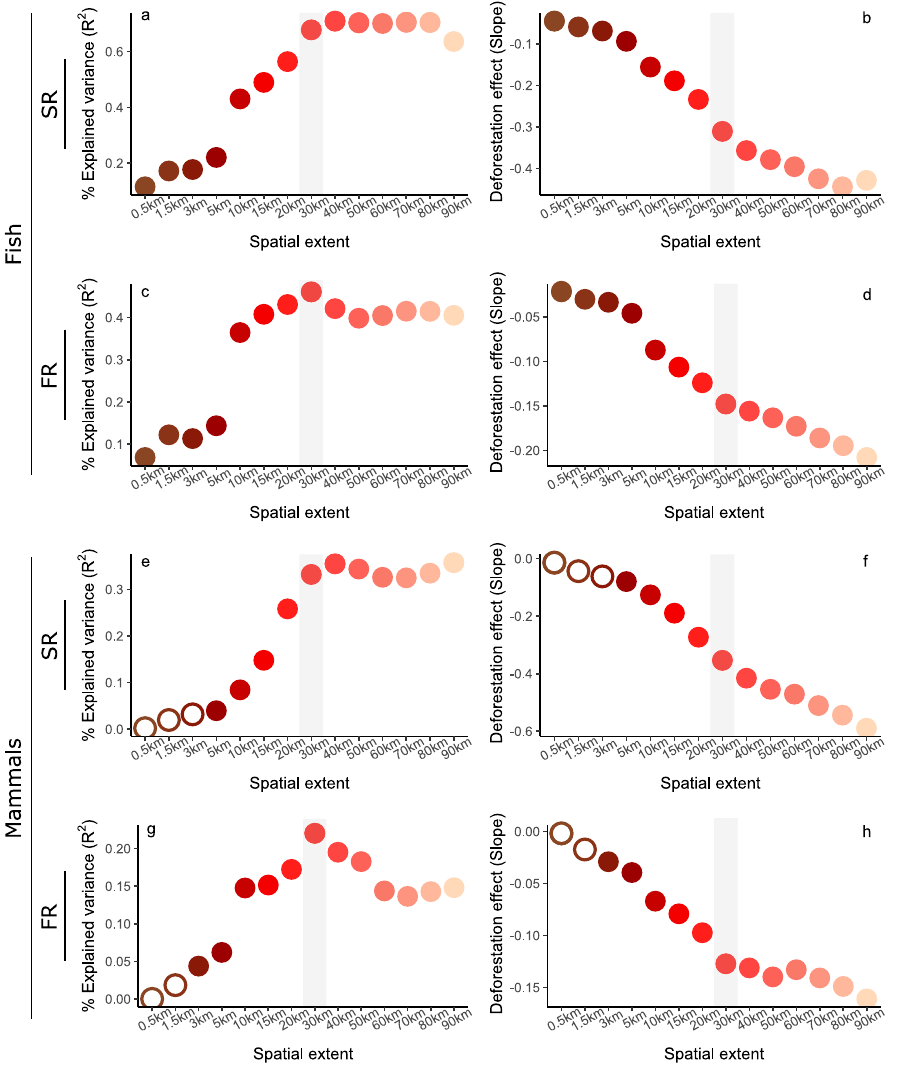
Fig. 3 Identi fi cation of the relevant spatial extent to measure deforestation impact on biodiversity. Left panels indicate variance explained by mixed models (R 2 ) for each spatial extent. Right panels indicate the strength of deforestation effect on biodiversity (slopes). Spatial extents account for deforested areas upstream from eDNA sampling sites. a , b Fish species richness (SR) models. c , d Fish functional richness (FR) models. e , f Mammal species richness models. g , h Mammal functional richness models. For each spatial extent, a speci fi c generalized linear mixed model accounting for site network position and basin identity as random effects was built for each biodiversity facet. Signi fi cant ( p < 0.05) and non-signi fi cant ( p > 0.05) models assessed with Wald ’ s tests are indicated by fi lled and open circles, respectively (Supplementary Table 1). Fish: n = 64 sites and mammals: n = 74. Colour shades are consistent with spatial extents. Grey vertical bars indicate models with highest R 2 or R 2 reaching a plateau, with less than 5% variation between successive spatial fi sh and mammals, respectively) and 28% less functional richness (22% and 33% for fi sh and mammals, respectively) in deforested sites than in non-deforested ones. This corresponded to average losses of 13 and 4 species for fi sh and mammal communities, respectively, in deforested sites. The fi sh's functional structure was represented by the two fi rst axes of a principal coordinate analysis (PCoA) of the life history and morphological traits of the species. The fi rst and second axes of the PCoA explained 37% and 24% of the variance and re fl ected locomotion and swimming/feeding strategies, respectively (Fig. 5a; Supplementary Table 2). In most non-deforested sites, the functional richness of the fi sh communities (the size of community convex hulls) was high but relatively lower in the deforested sites. The lower functional richness at the deforested